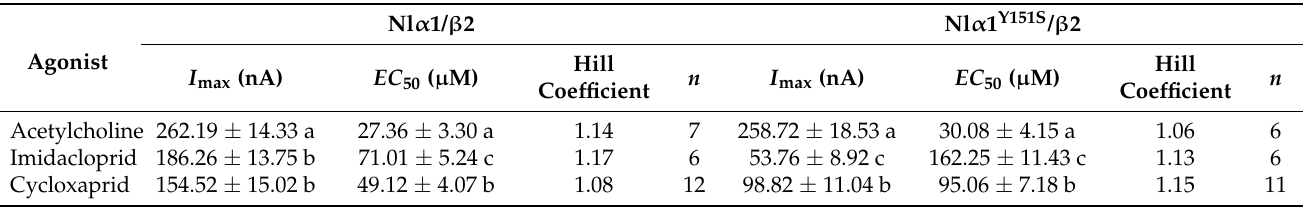
Table 1. Agonist potency of acetylcholine, imidacloprid, and cycloxaprid on recombinant receptor Nl α 1/ β 2 expressed in Xenopus